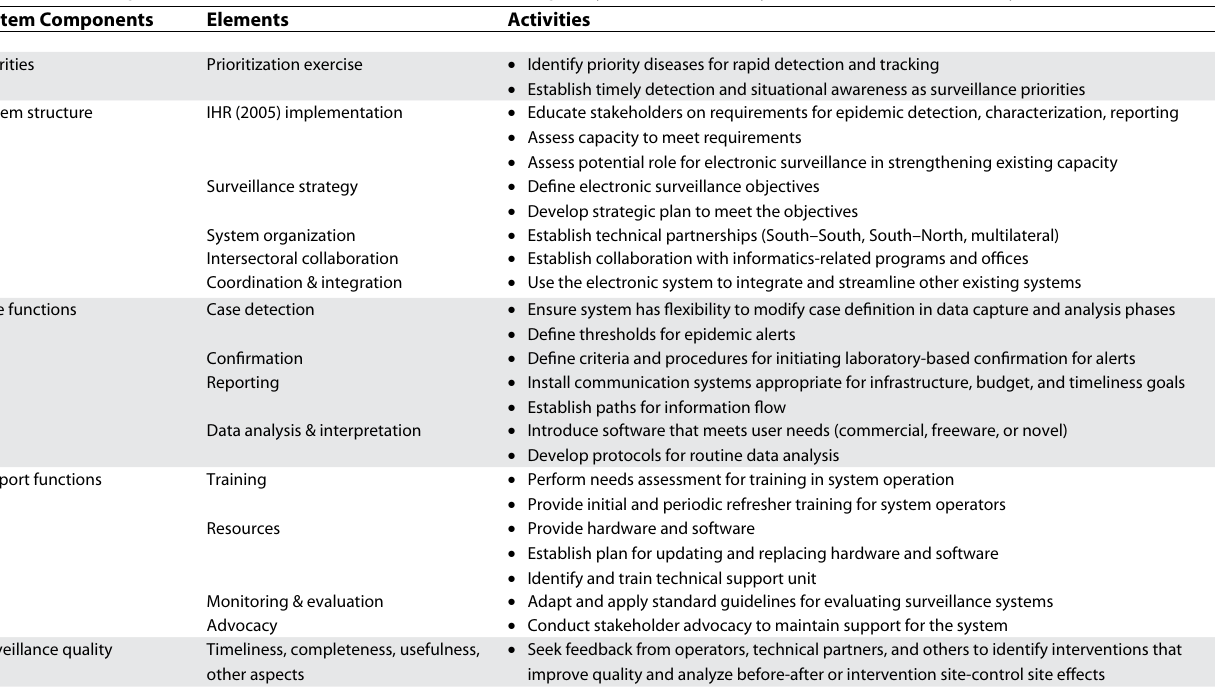
Table 2. Strategic and Operational Surveillance Planning: Key Activities for Syndromic Surveillance Systems System Components